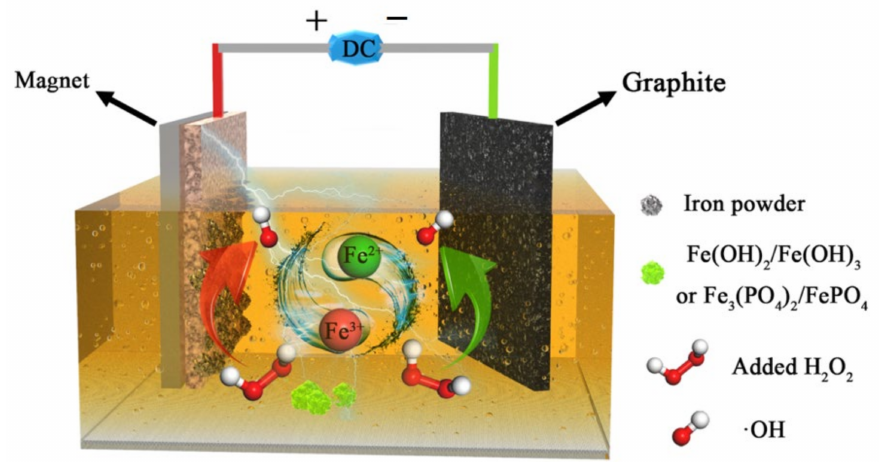
Figure 1. Schematic diagram of the experimental